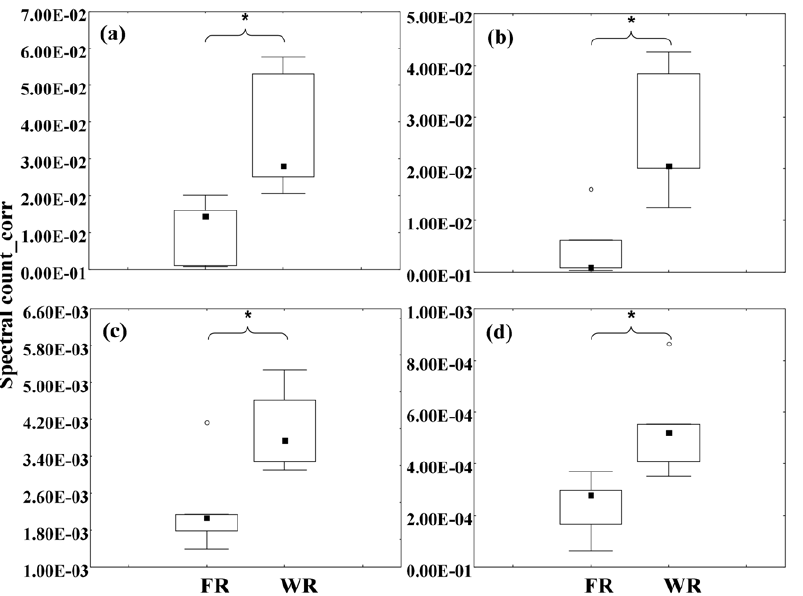
Figure 3. Quantities of four peptides/proteins significantly differentially expressed in foundress-reared vs. worker-reared P. metricus fifth-instar larvae. Quantities of four peptides/proteins significantly differentially expressed in foundress-reared (FR; putative worker- destined) vs. worker-reared (WR; putative gyne-destined) P. metricus fifth-instar larvae: median (dark squares), 25 th -75 th percentiles (brackets), and outliers (open circles). Stars denote significant differences (Mann Whitney U-test, p # 0.05, n=5 per group). Y-axis: spectral count for individual peptides/proteins corrected for overall spectral count. Sequences are homologous to: (a) arylphorin of the boll weevil (NCBI accession AAN63347); (b) serpin (contig 46732, rf 18257); (c) imaginal disc growth factor 4 (contig 46769); (d) shrub (contig 32130).